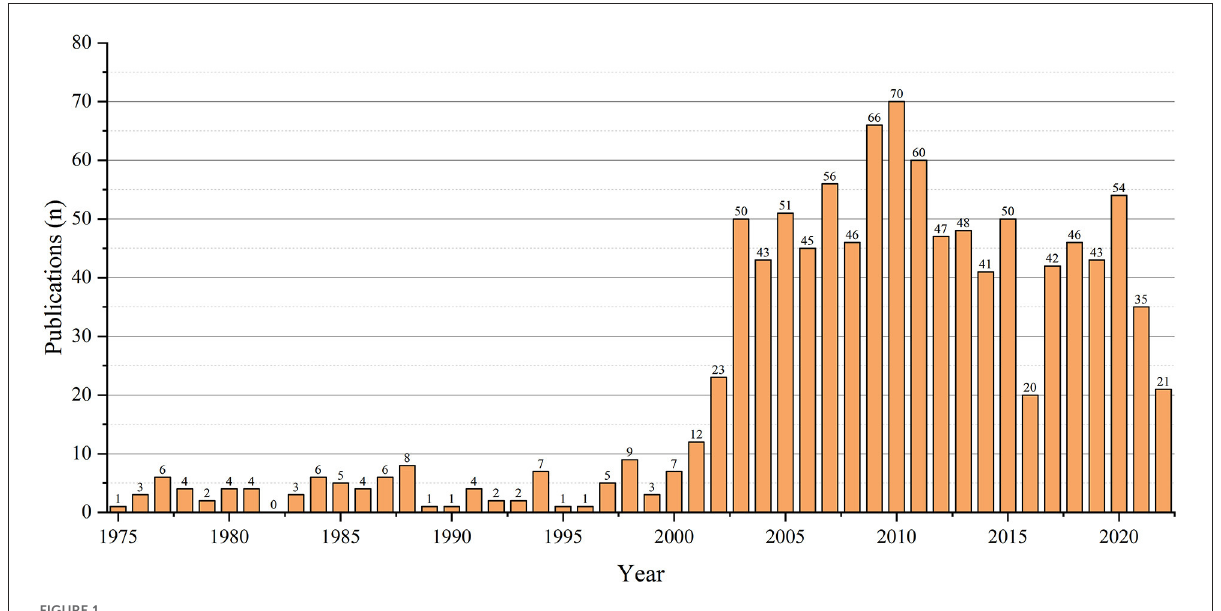
FIGURE1 Annual publications on monkeypox